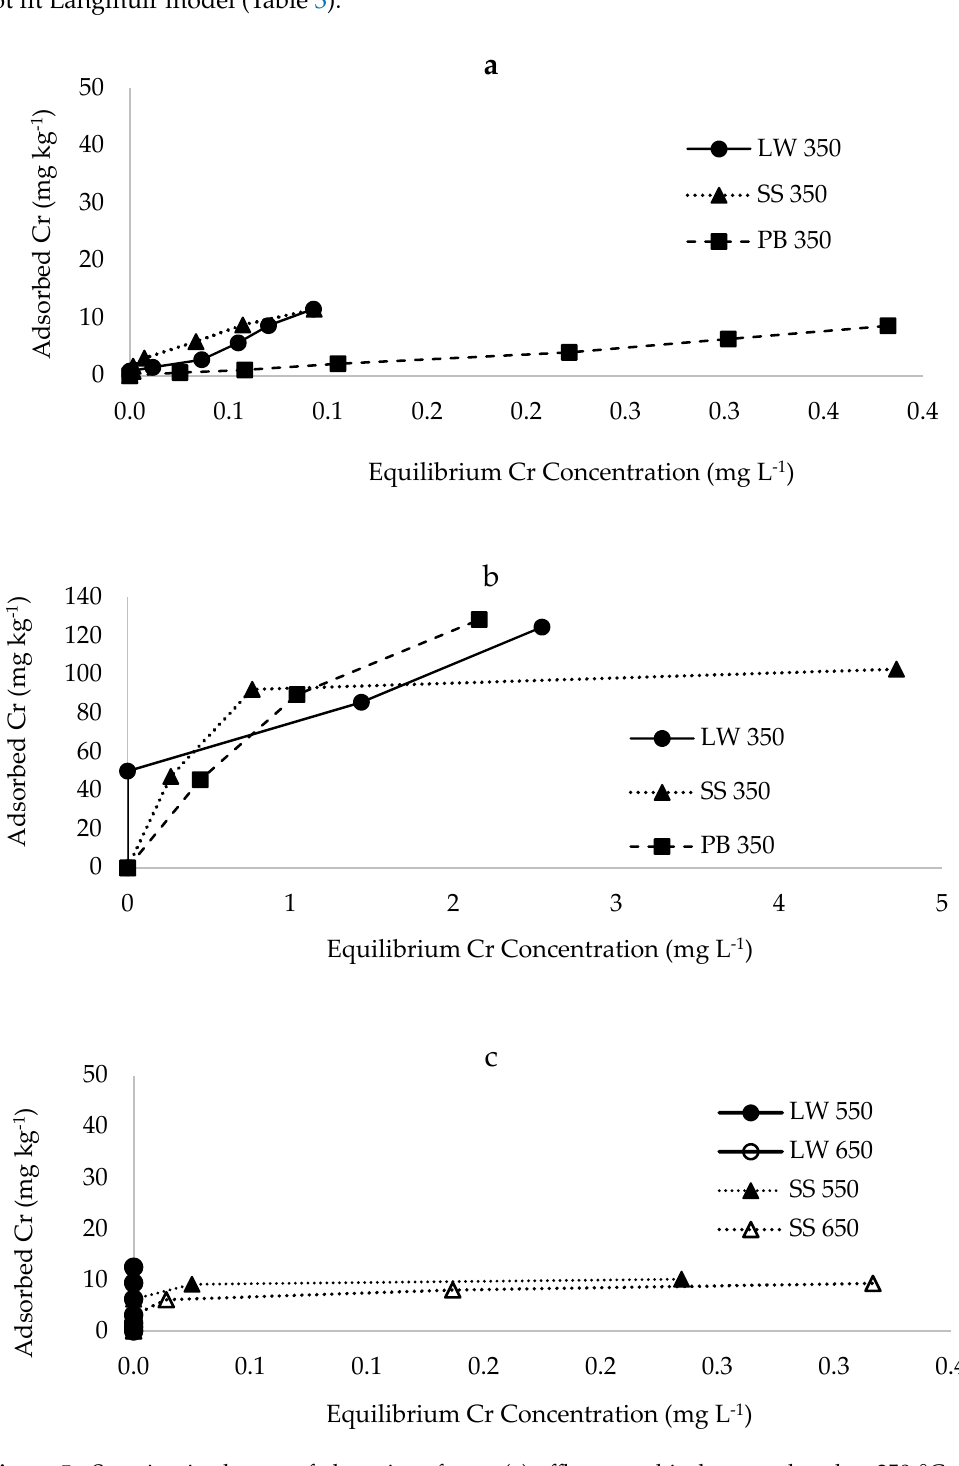
Figure 5. Sorption isotherms of chromium from: ( a ) e ffl uent on biochar pyrolysed at 350 ◦ C, ( b ) single metal on biochar pyrolysed at 350 ◦ C and ( c ) e ffl uent on biochar pyrolysed at 550 and 650 ◦ C. LW = latrine waste biochar, SS = sewage sludge biochar, PB = pine-bark